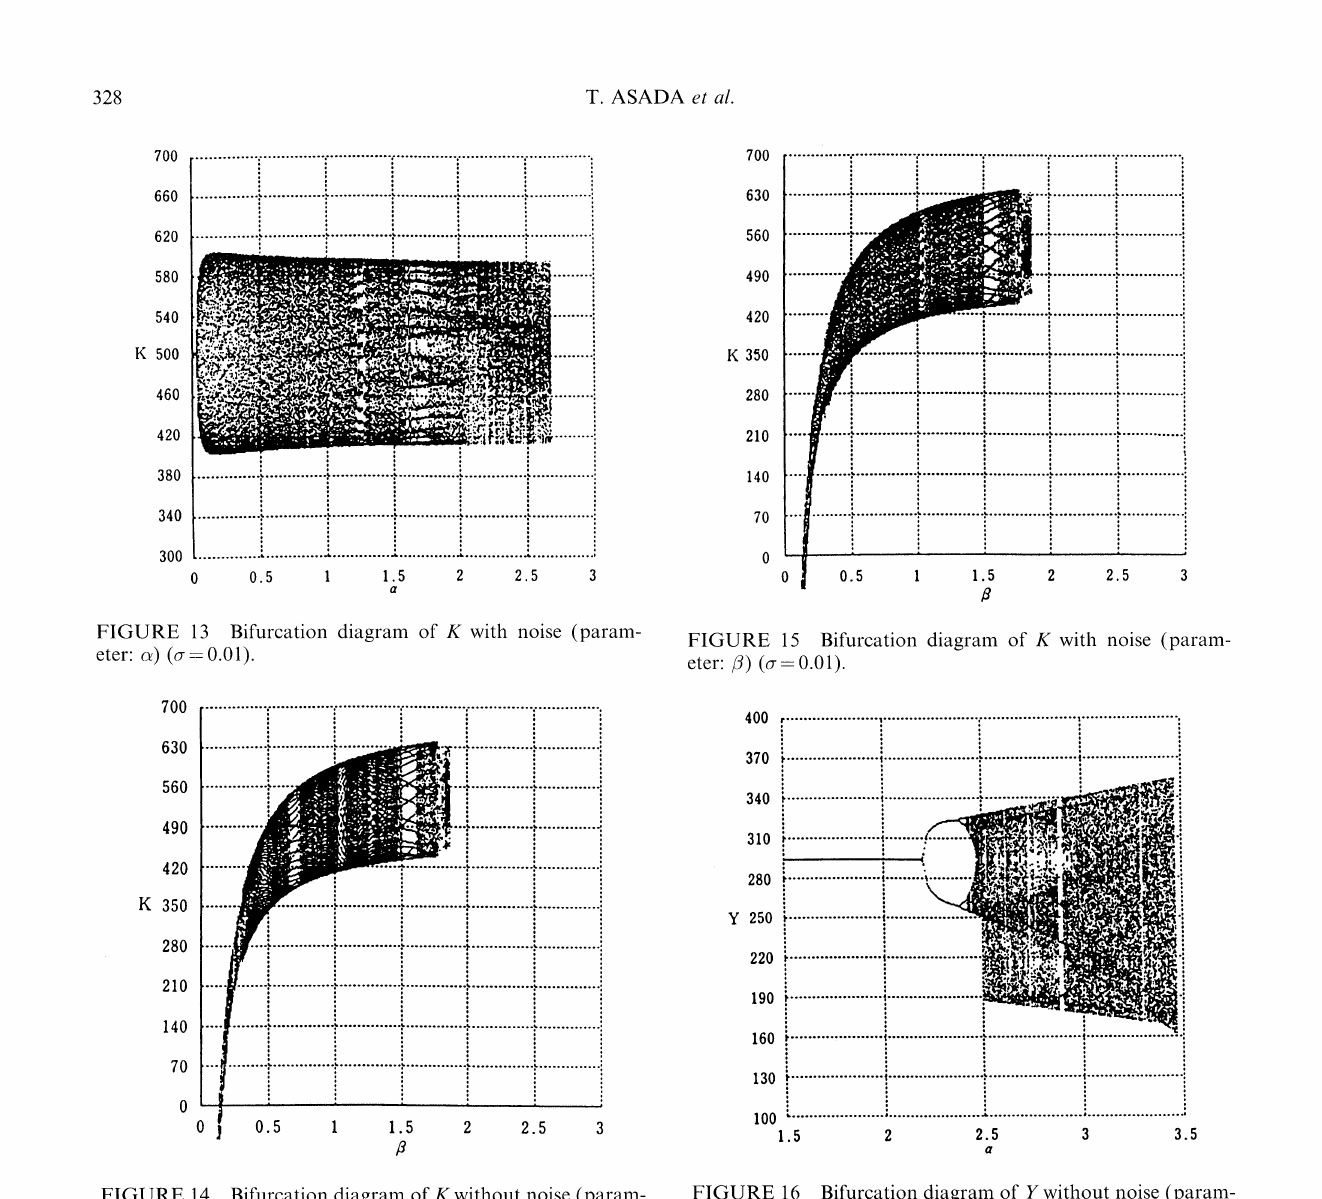
FIGURE 14 Bifurcation diagram of K without noise (param- eter:/3).